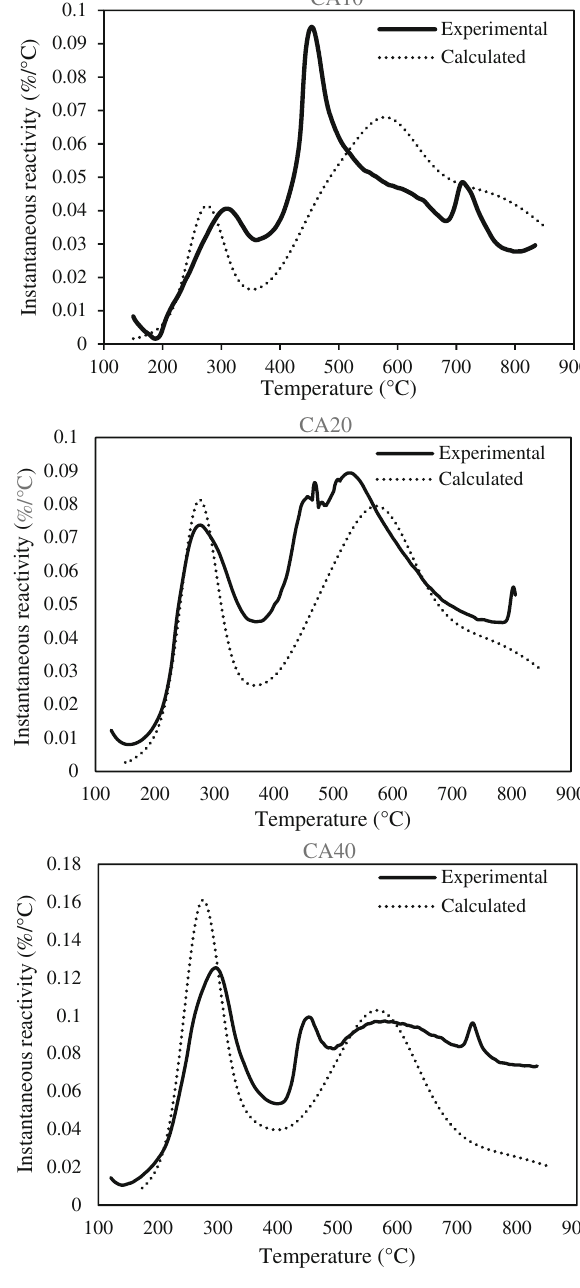
Fig. 3 DTG plots of different coal-algae blends at 10 (cid:3)